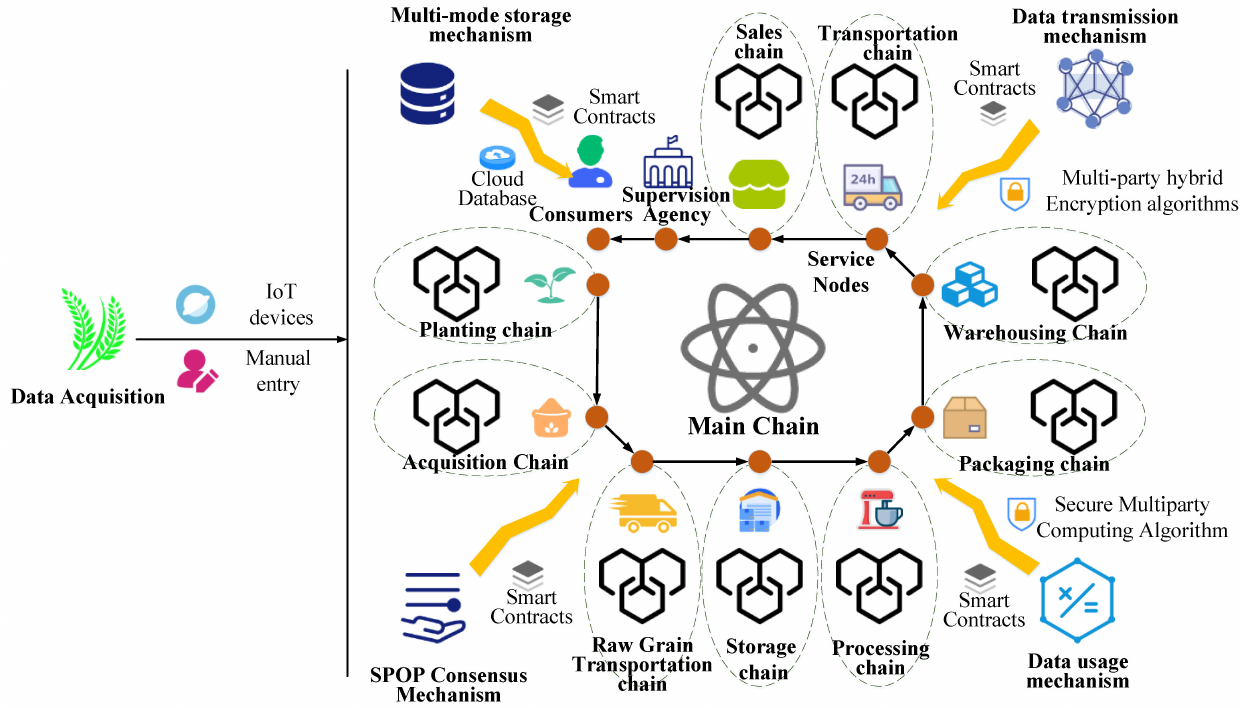
Figure 1. Schematic diagram of MBRRSM